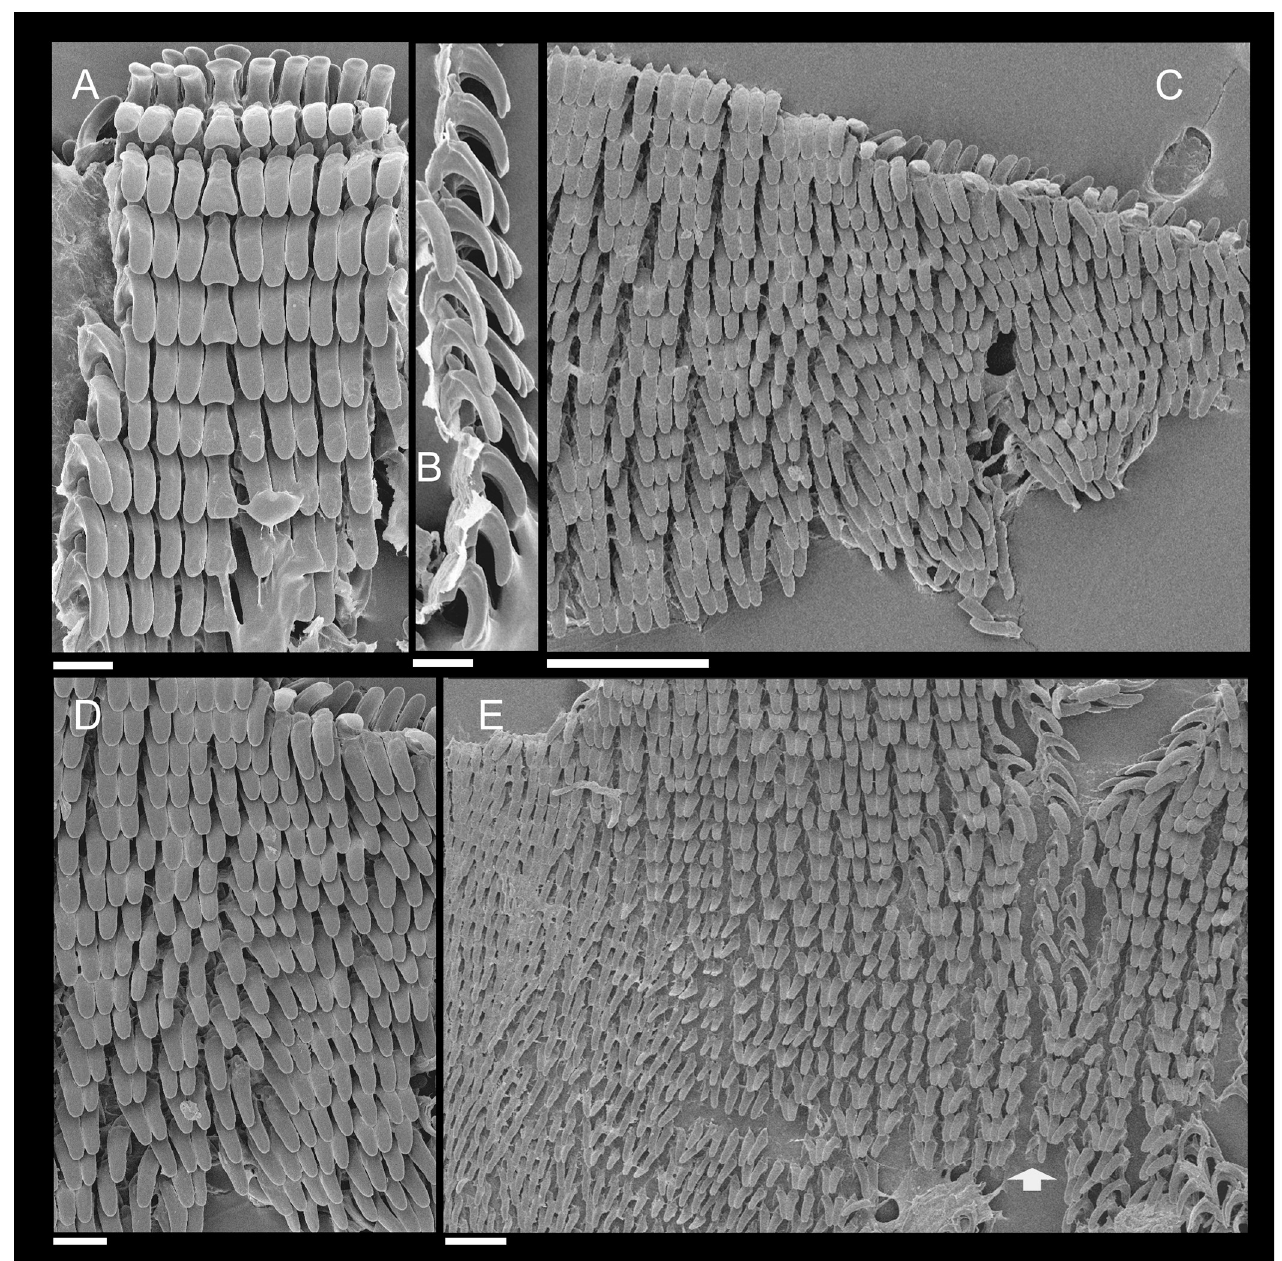
Fig 18. Anthinus savanicus , radulae in SEM. (A) holotype MZSP 154391. Detail of central region, scale = 50 μ m; (B) same, detail of column in profile, scale = 50 μ m; (C) same, detail of right region, scale = 200 μ m; (D) paratype MZSP 153897, detail of right region, scale = 50 μ m; (E) same, central region, scale = 100 μ m. White arrows indicating rachidian